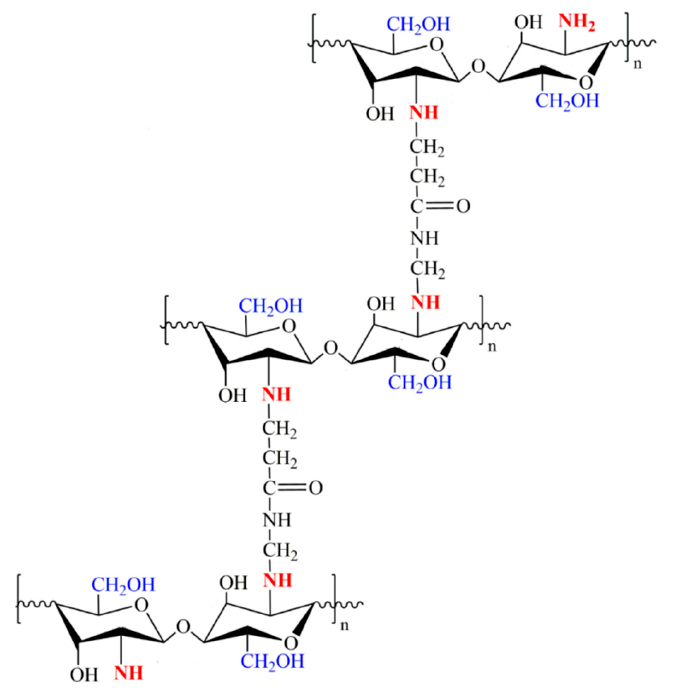
Figure 5. Proposed structure of the crosslinked copolymer of chitosan and NMA.